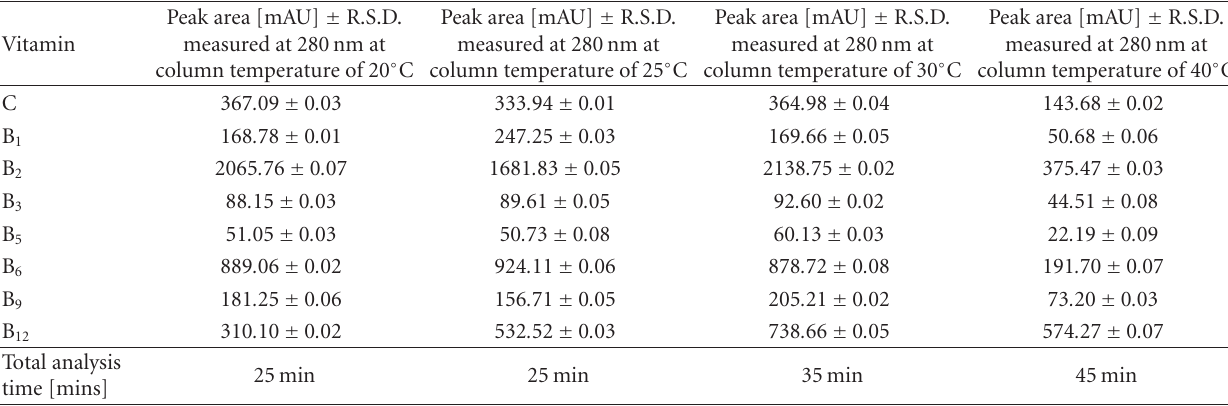
Table 1: Column temperatures study. Experimental results (peak area mean ± RSD) obtained from six separate runs of a standard sample (aqueous mixture of 8 water-soluble vitamins) at 4 di ff erent column temperatures. The last row of the table reports run time in minutes. HPLC conditions used were those reported in the main text.